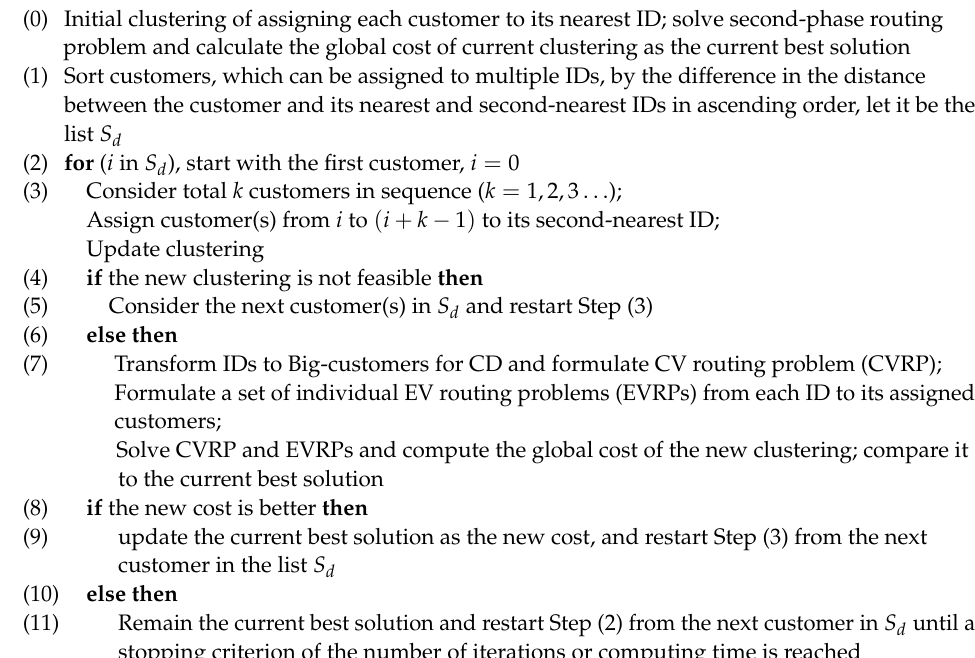
Algorithm 1 The improving procedure of first-phase